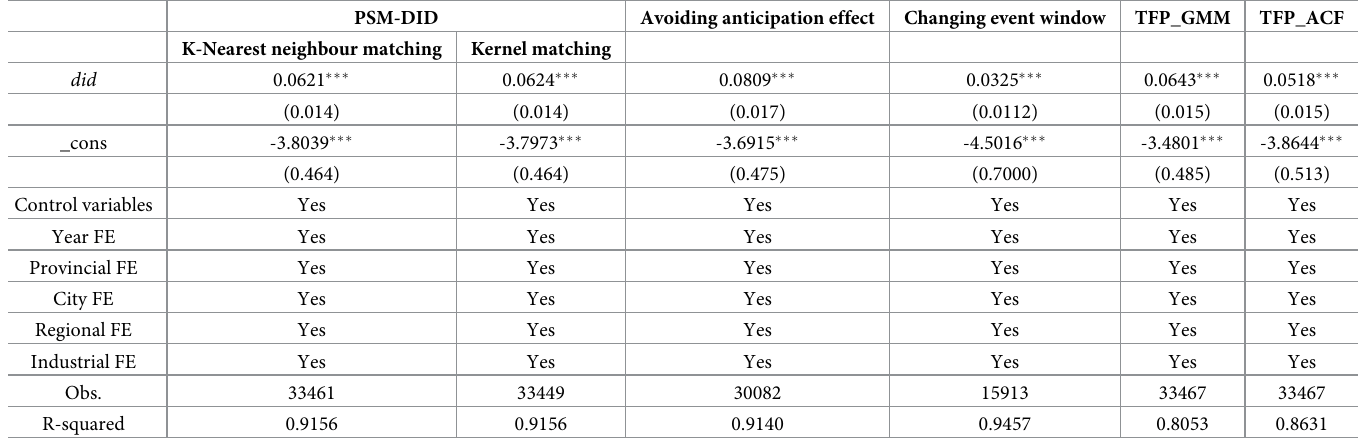
Table 4. Robustness test